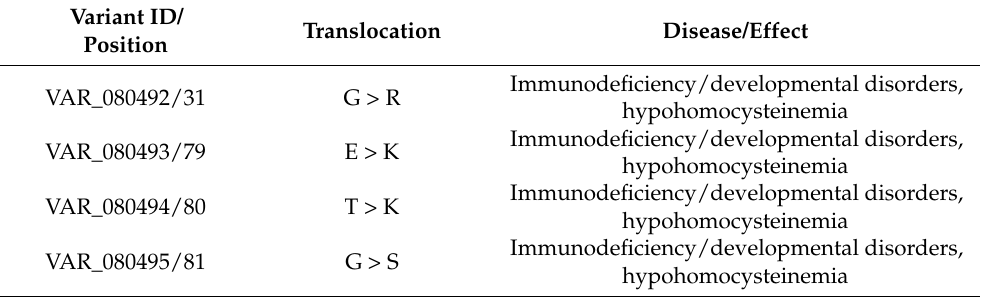
Table 2. Nrf2 variants associated with disease processes